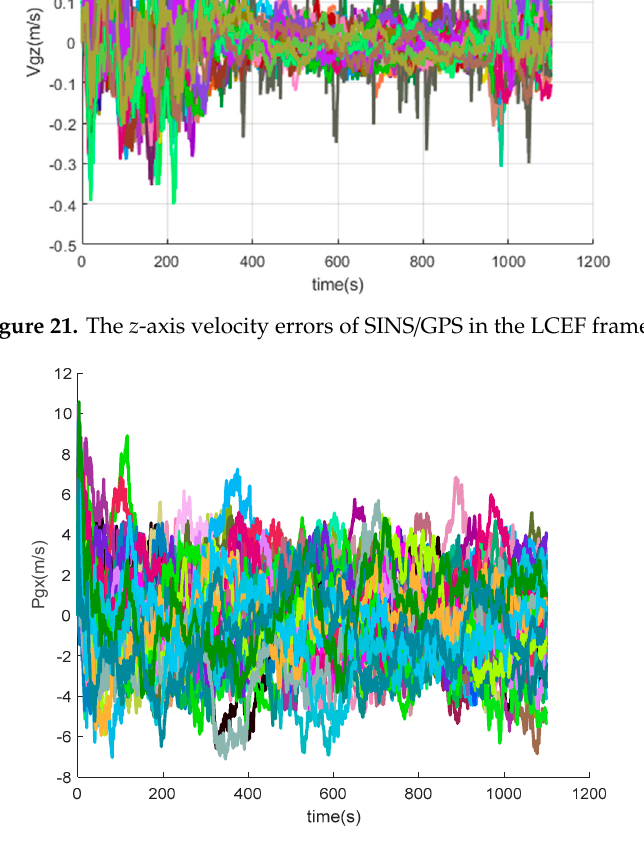
Figure 22. The x -axis position errors of SINS / GPS in the LCEF frame.